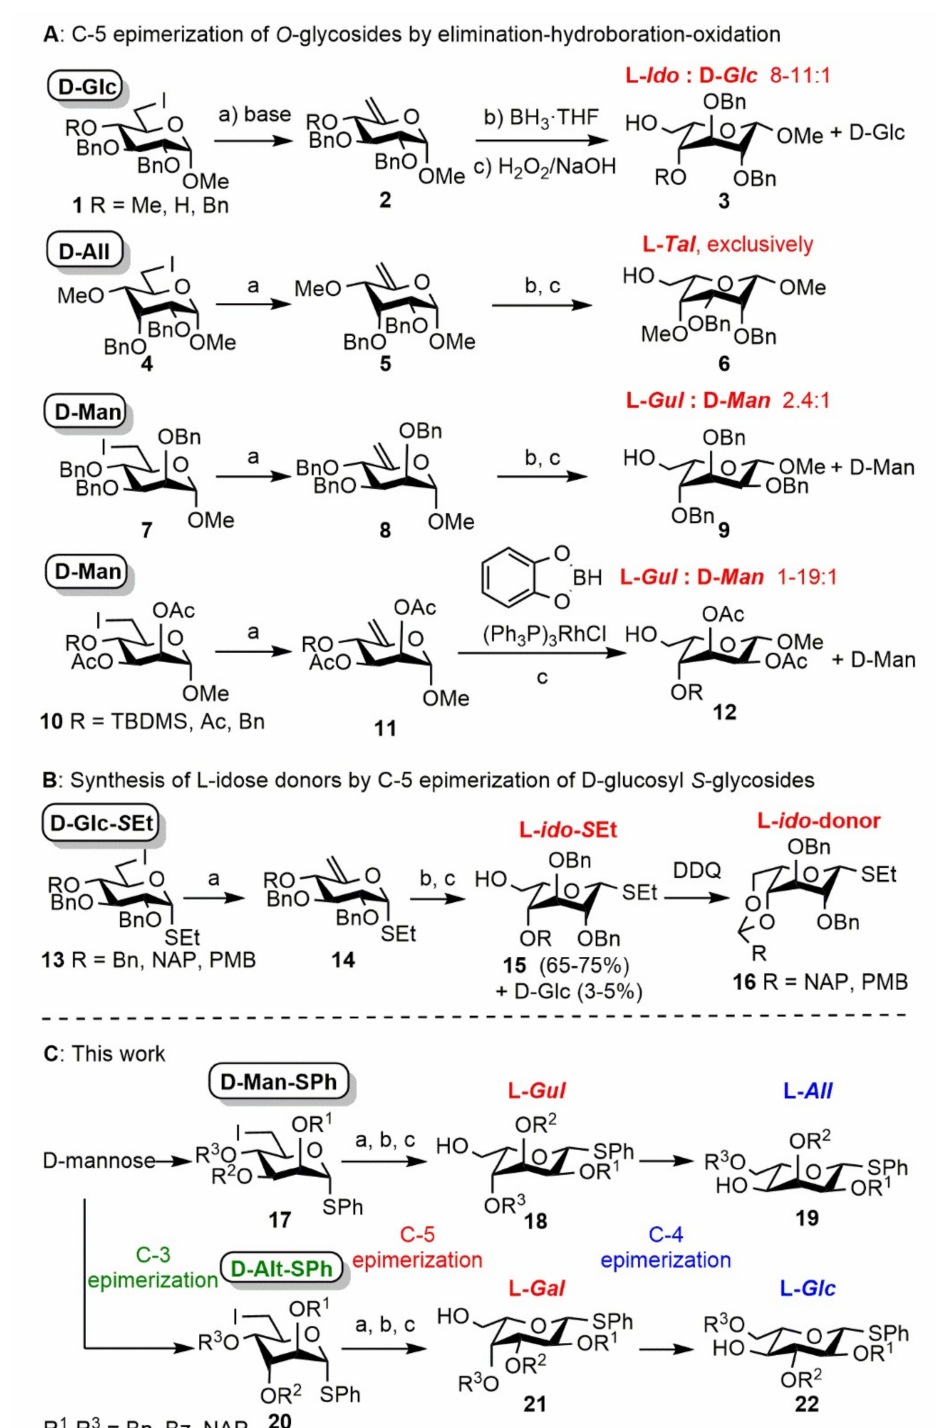
Scheme 1. Literature results on C-5 epimerization of O - and S -glycosides by using elimination- hydroboration-oxidation (( A ) [25,26,67]; ( B ) [65,66].), and planned synthetic route to orthogonally protected L -gulo-, allo-, galacto, and glucopyranosyl thioglycosides from D -mannose ( C ). The most common anomeric leaving group, thiophenyl, was chosen as the aglycone, and the incorporation of ether and ester protecting groups (that are non-participating and participating groups) into the C-2 position was also devised to make the resulting L -thioglycosides suitable for the synthesis of either α - or β -glycosides. Our